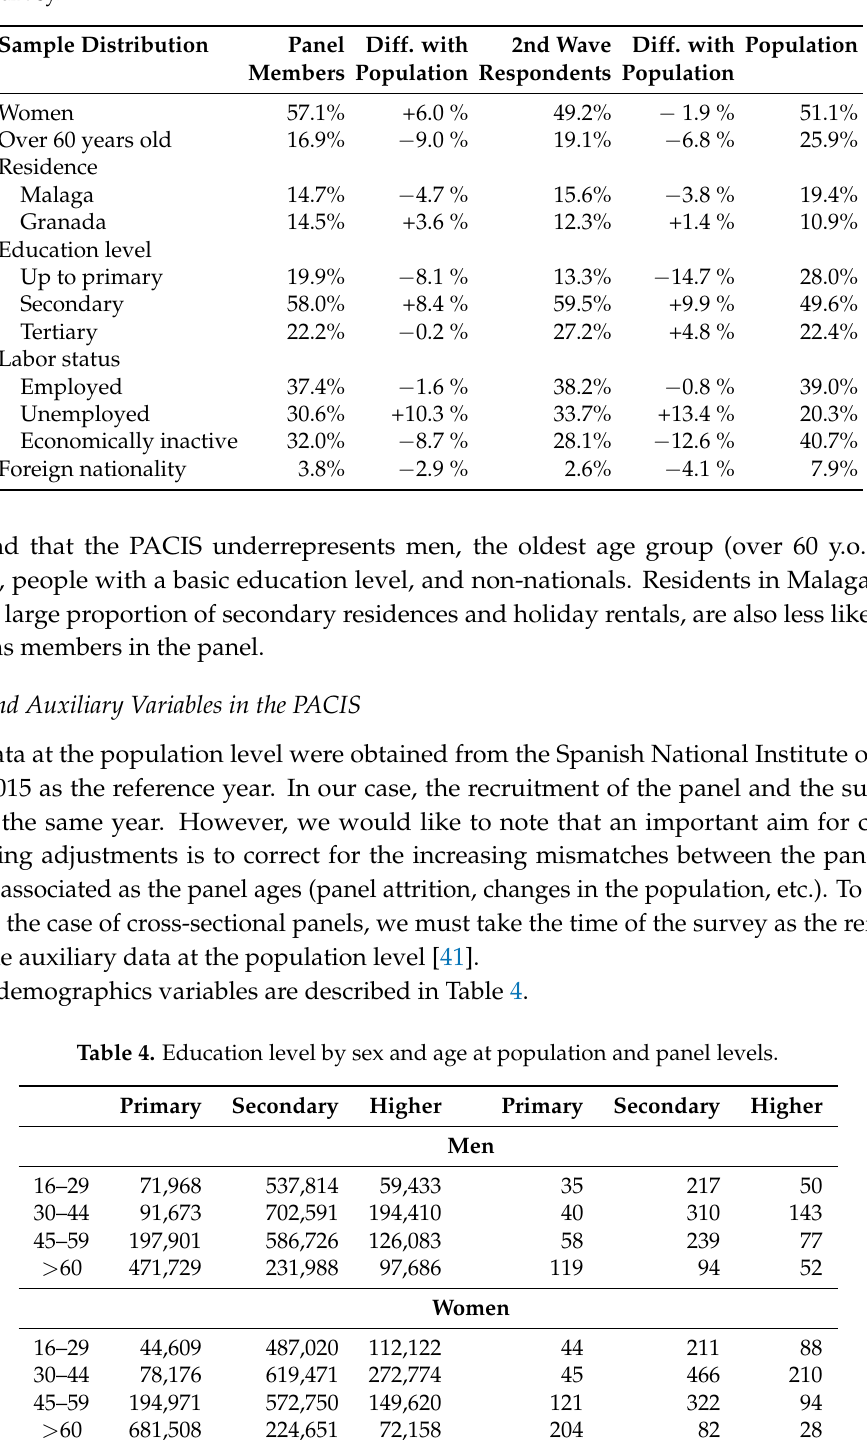
Table 3. Sample percentages for population, panel members, and respondents to PACIS Second Wave Survey.